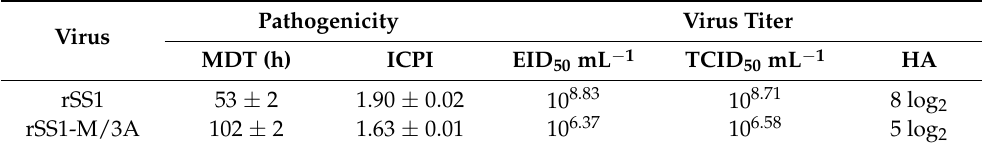
Table 1. Biological characteristics of the parental and mutant viruses *.